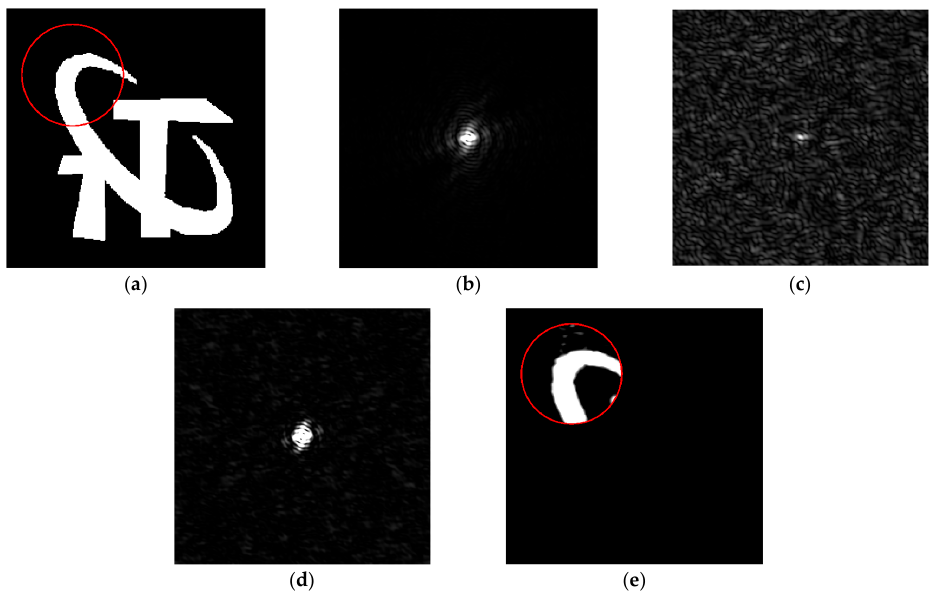
Figure 4. Block diagram of the imaging correlography with ptychography.